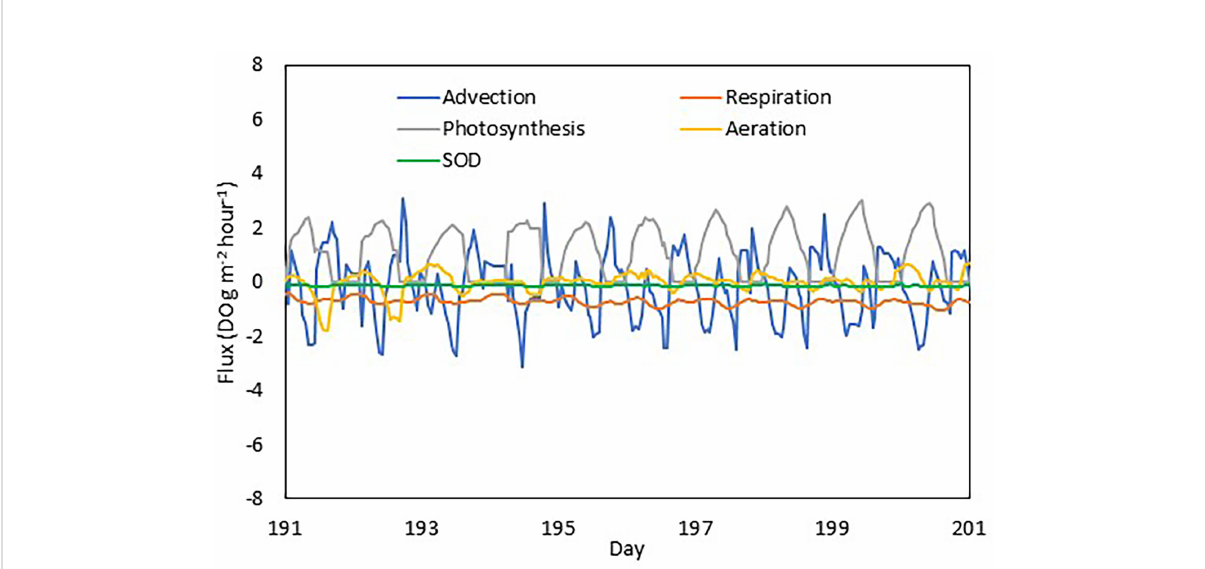
FIGURE 12 DO fl uxes from different processes at the upper estuary station XHH3851. Advection, photosynthesis and respiration are integrated in the water column, aeration is at the sea surface and sediment oxygen demand at the